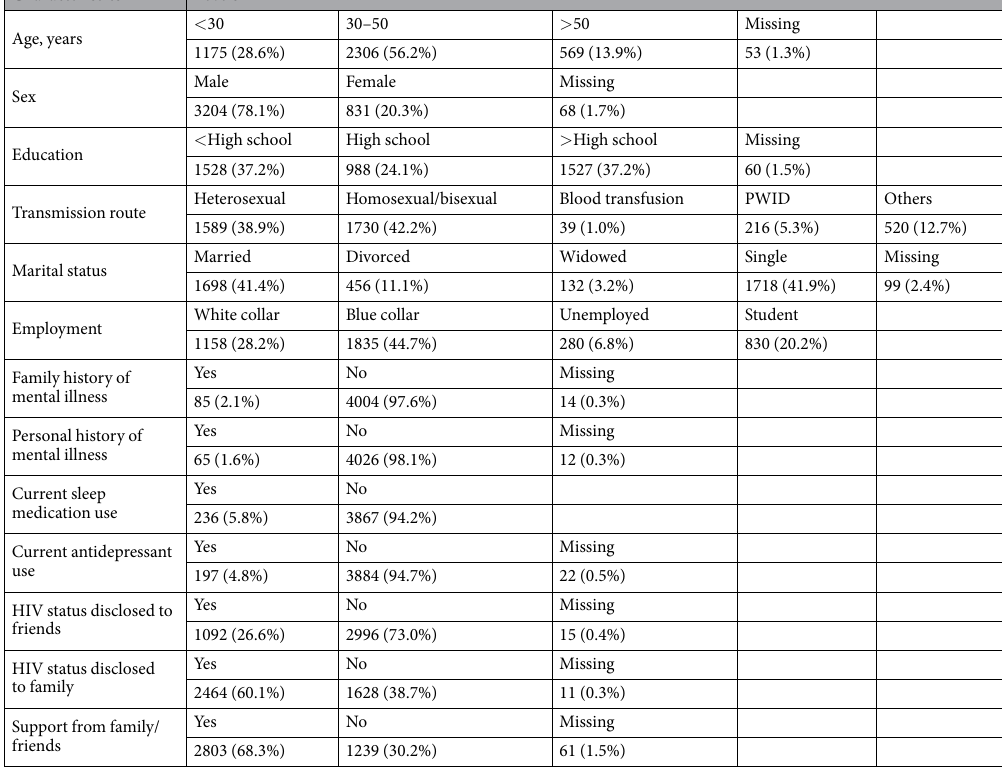
Table 1. Demographic characteristics for all 4103 subjects [n (%)].